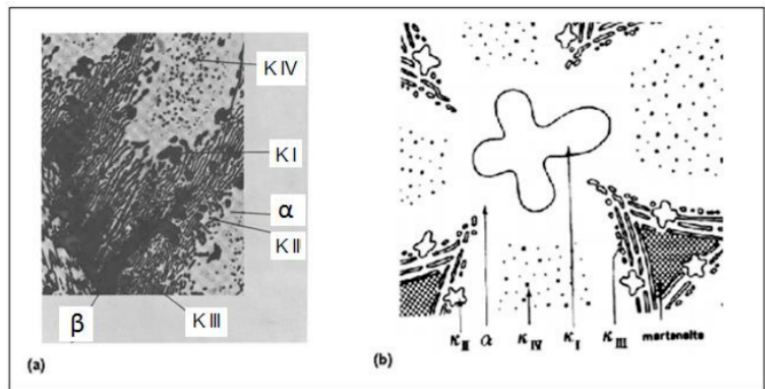
Figure 2. Distribution of the different phases and intermetallic components of the nickel aluminum–bronze cooled slowly: ( a ) optical microscopy [4] and ( b ) schematic representation [8].